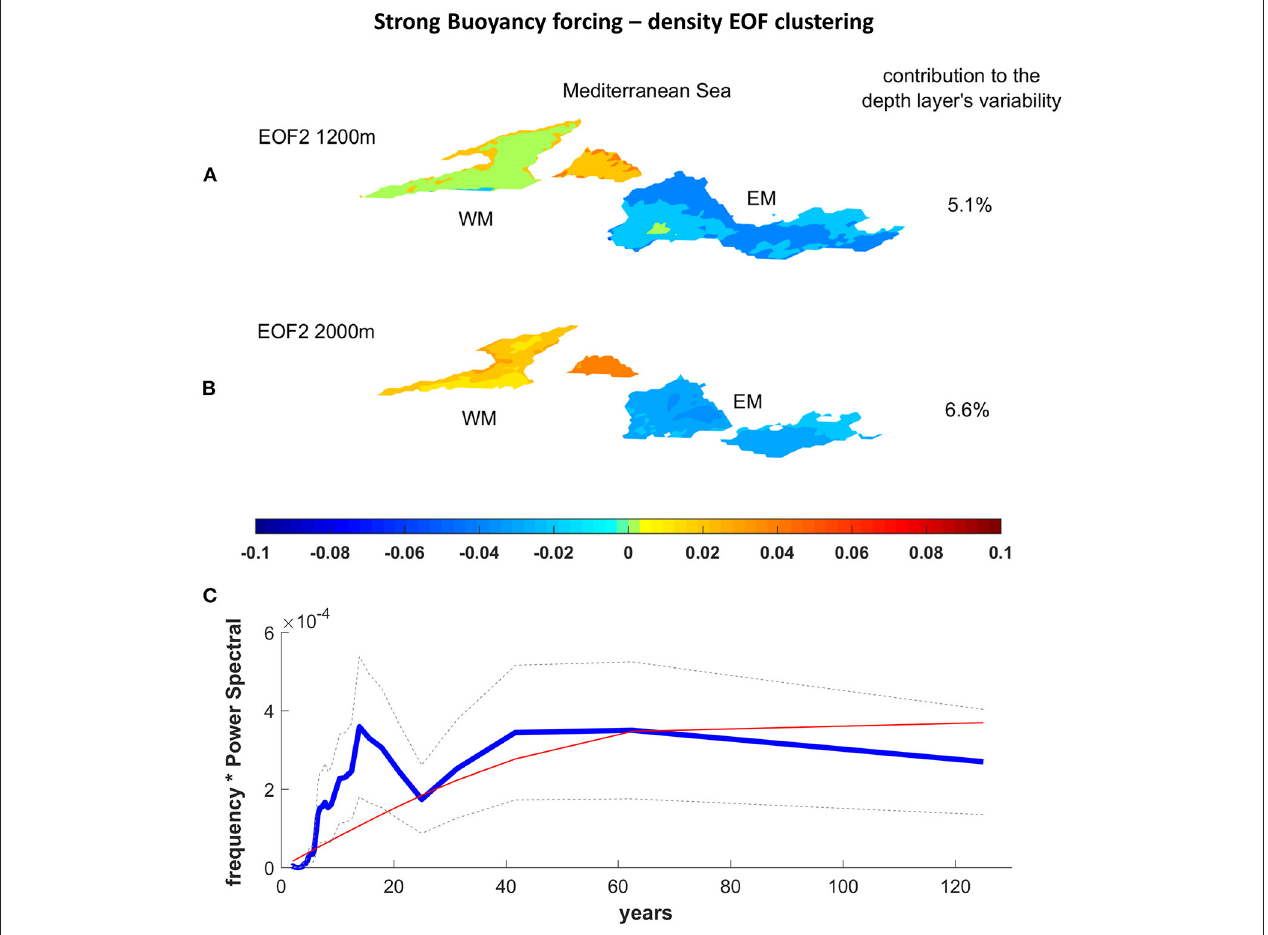
FIGURE 12 | The second EOF modes of 1,200 (A) and 2,000m (B) depth layers of the SBF experiment, whose expansion coefficients are well-correlated. Here, the variance-preserving spectrum of the 2,000m first EOF is presented as (C)